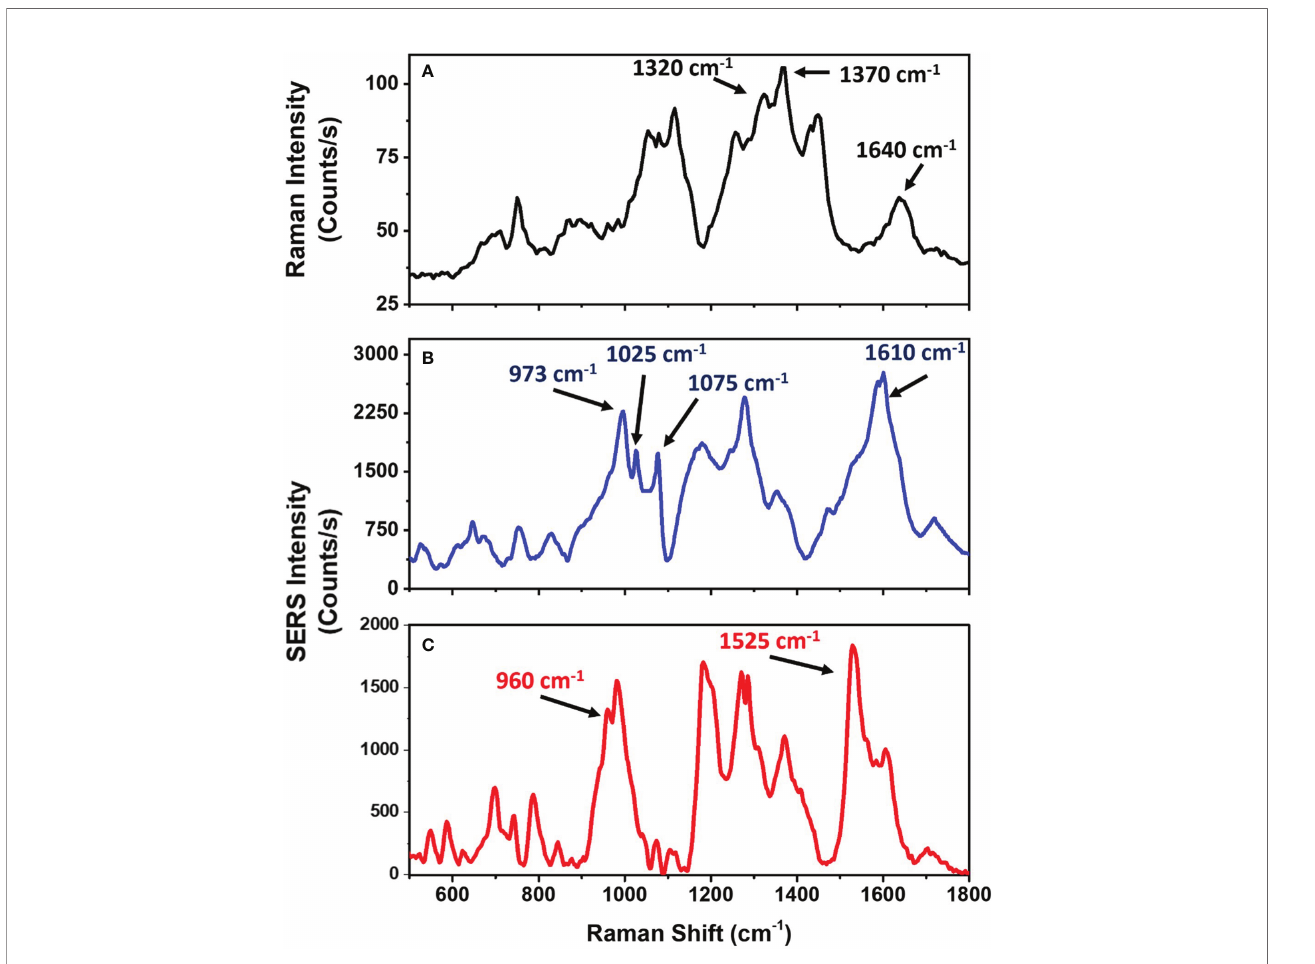
FIGURE 5 | Raman and SERS spectra of LPS from E . coli and K . pneumoniae. (A) Raman spectrum of LPS powder from E. coli. (B) SERS spectrum of 50 nm AuNPs incubated with 1 mg/mL of LPS from E . coli . (C) SERS spectrum of 50 nm AuNPs incubated with 1 mg/mL of LPS from K .